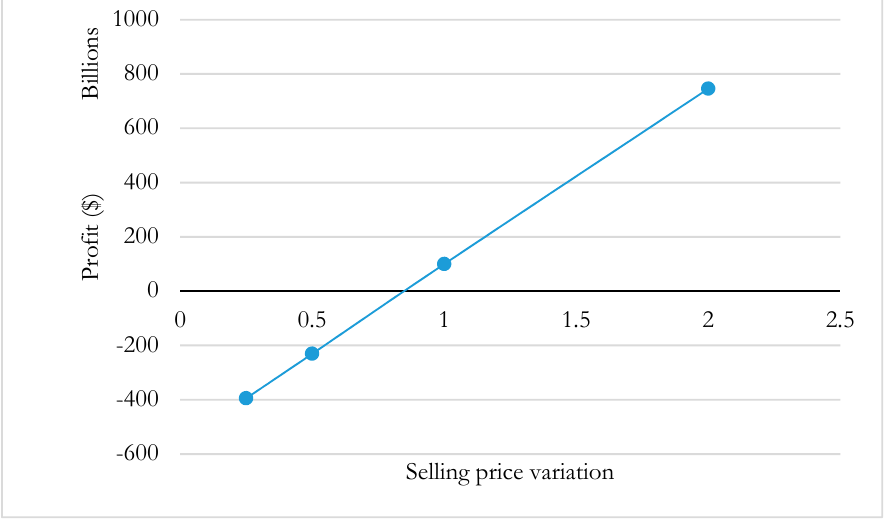
Figure 8. Profatibility changes with variation in demand.